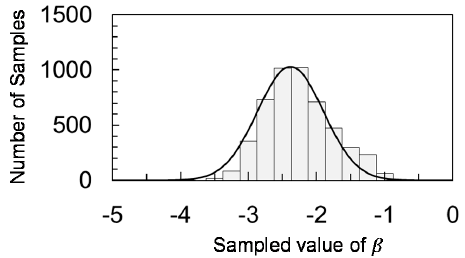
Figure 7. Histogram for sampled values of common parameter β generated by the Markov Chain Monte Carlo (MCMC) method. Solid line is normal distribution that approximately fits the histogram.